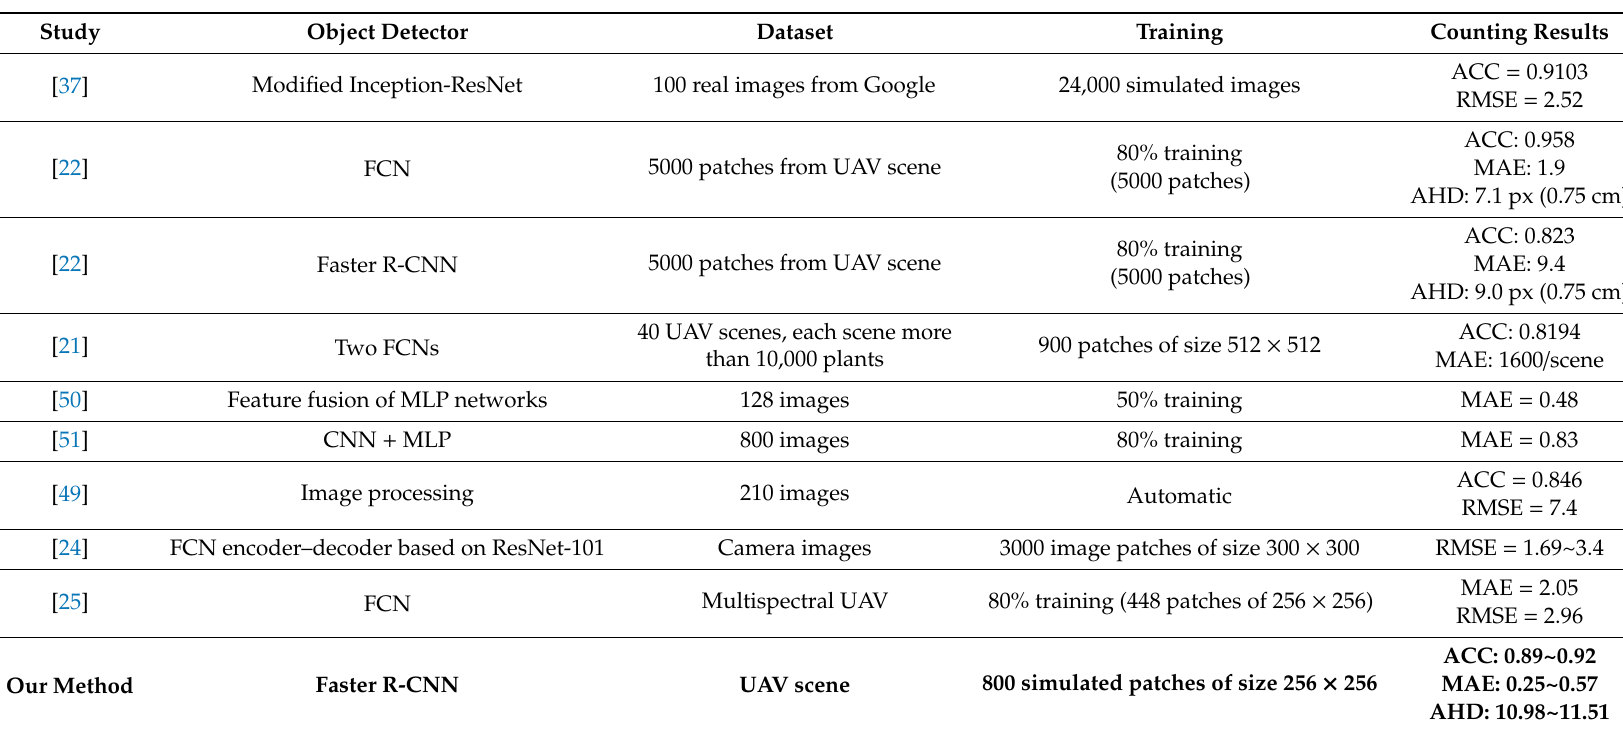
Table 6. Comparison between the proposed method and other state-of-the-art counting methods in precision farming (ACC: Accuracy; RMSE: Root mean squared error; MAE: Mean absolute error; AHD: Average Hausdor ff distance; FCN: Fully convolutional network; CNN: Convolutional neural network; MLP: Multi layer perceptron; UAV: Unmanned aerial